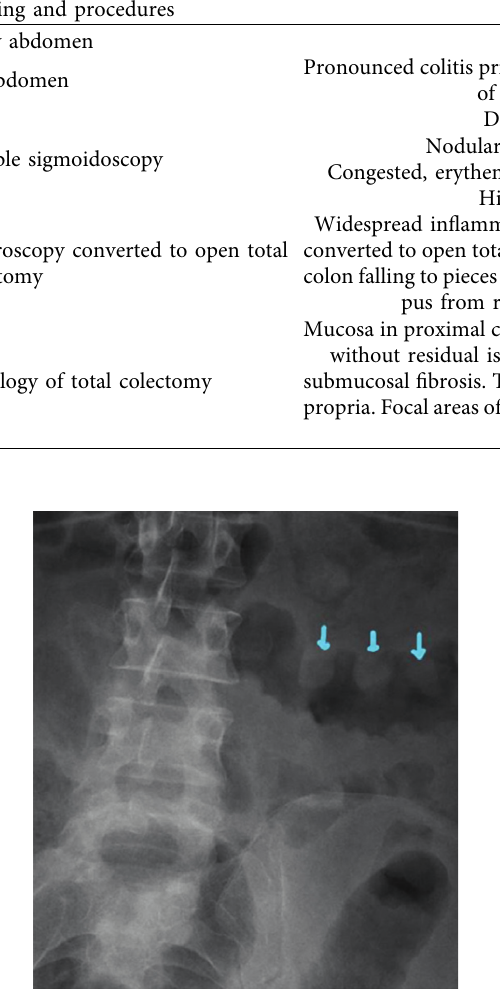
Figure 1: Abdomen X-ray showing thumbprinting sign.